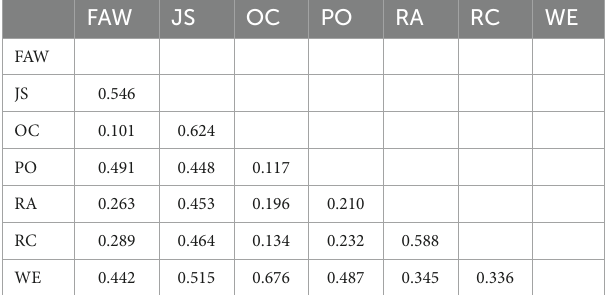
TABLE 4 Heterotrait-Monotrait ratio (HTMT) ratio.